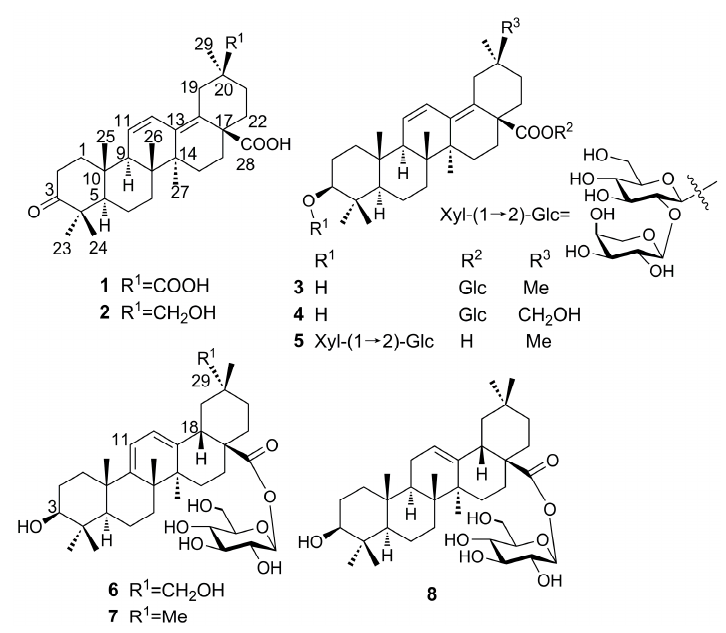
Figure 1. Chemical structures of triterpene derivatives 1 – 8.